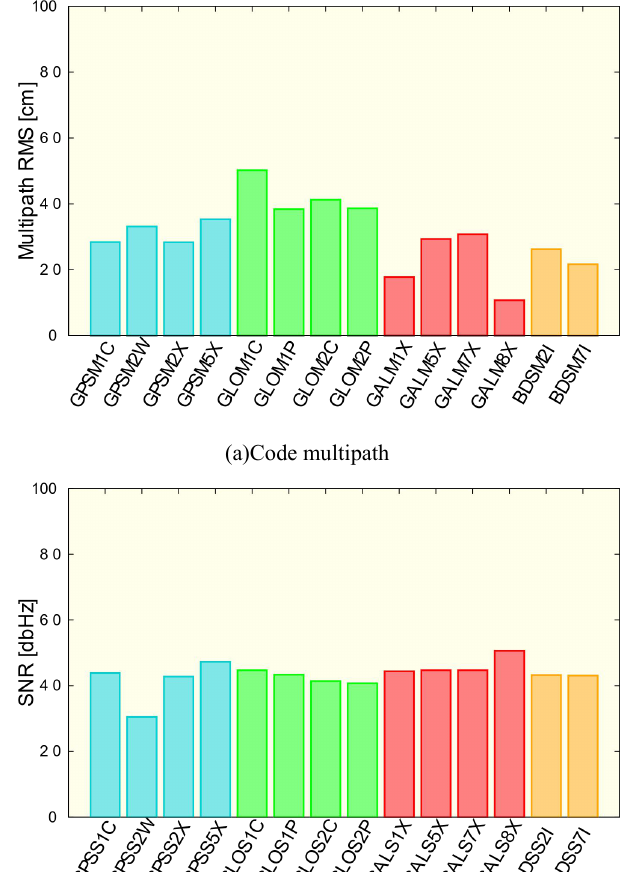
Figure 7. Quality inspection